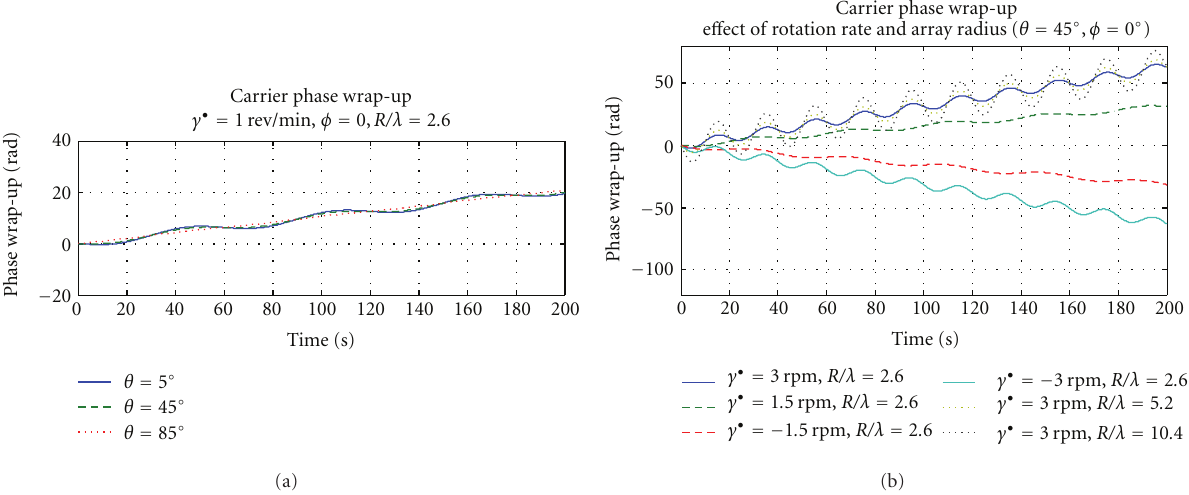
Figure 3: E ff ect of several parameters on the phase wrap-up accumulation.